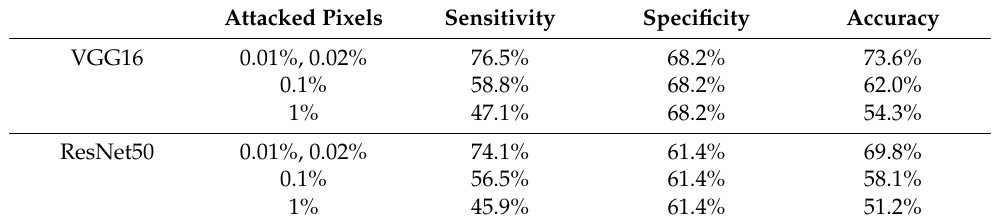
Table 1. Classification of benign and malignant mammograms after malicious attack for mini-MIAS. Attacked